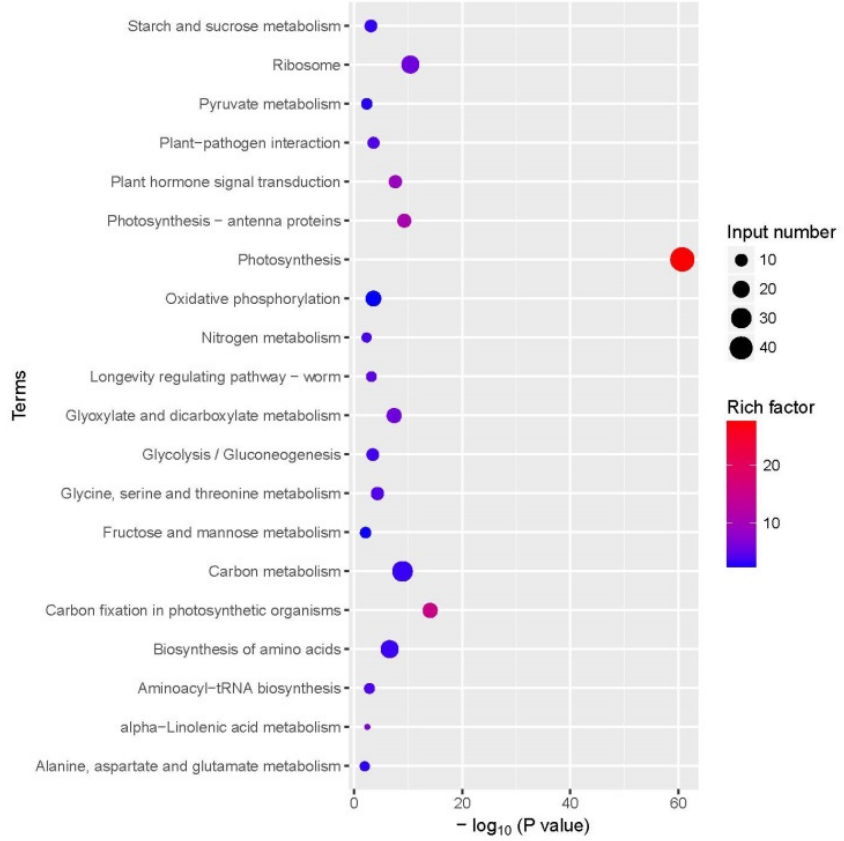
Figure 4. Kyoto Encyclopedia of Genes and Genomes (KEGG) enrichment analysis based on DEGs induced by COS under − 4 °C treatment. The significance of enrichment is shown on the horizontal coordinates (represented by − log 10 ( p -value), the greater the value, the more significant the enrichment), and the KEGG pathway is shown on the longitudinal coordinates. The size of the dots indicates the number of di ff erent genes contained in the KEGG pathway, and the color of the dots indicates the degree of rich factor enrichment.